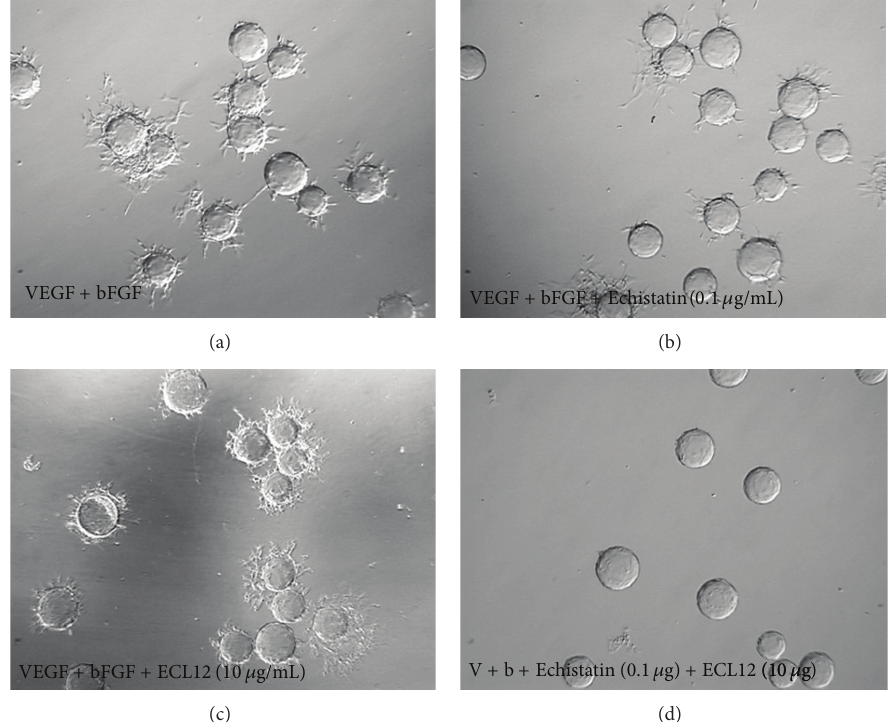
Figure 8: Integrin alpha v beta3 antagonist Echistatin and integrin alpha 2 beta 1 antagonist ECL12 differentially but synergistically inhibit sprout angiogenesis of HDMEC in fibrin. VEGF (30 ng/mL) and bFGF (25ng/mL) induced sprout angiogenesis in fibrin (a). Echistatin at very low dose (0.1 microgram/mL) had mild inhibitory effect on sprout angiogenesis of HDMEC in fibrin (b). While disintegrin ECL12 had no inhibitory effect on sprout angiogenesis in vitro (c), it synergistically enhanced the inhibition of sprout angiogenesis by Echistatin